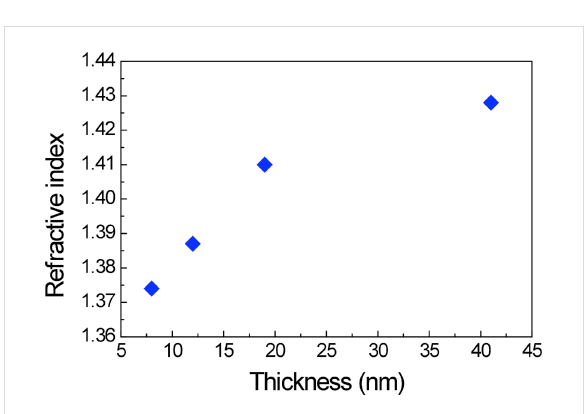
Figure 3: Refractive index, n , at 750 nm, evaluated by spectroscopic ellipsometry of silica layers deposited onto a glass substrate at a fixed withdrawal speed (50 mm/min) for different EtOH dilution (v/v = 1:0, 1:2, 1:4,